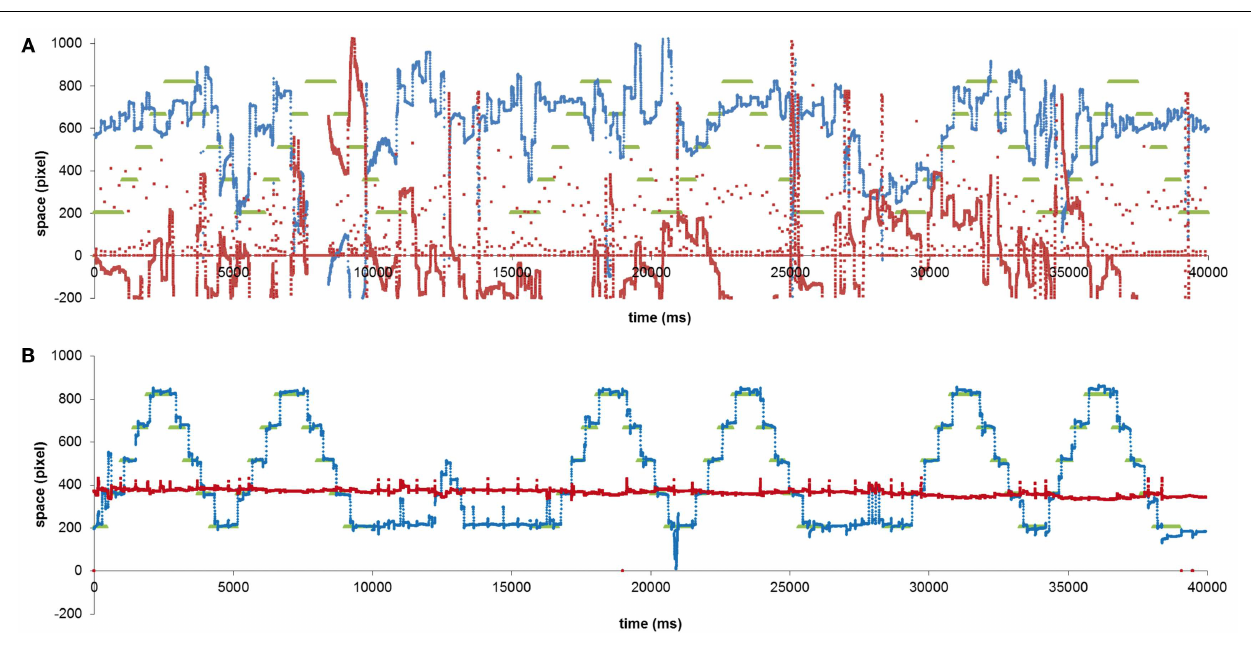
FIGURE 4 | MA (A) and EP (B) ocular behavior in a non-verbal saccadic task. The green lines indicate the dot positions, the red lines indicate the y coordinate of the eye movements and the blue lines the x coordinate.